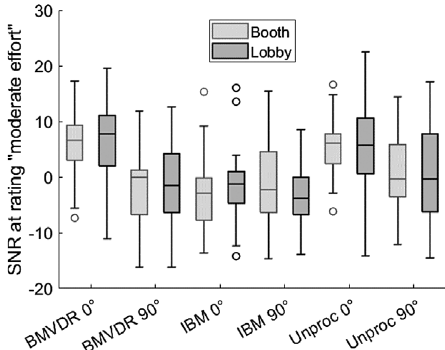
Figure 4. One-third octave band levels of the background noises in lobby (black) and in the listening booth (gray).